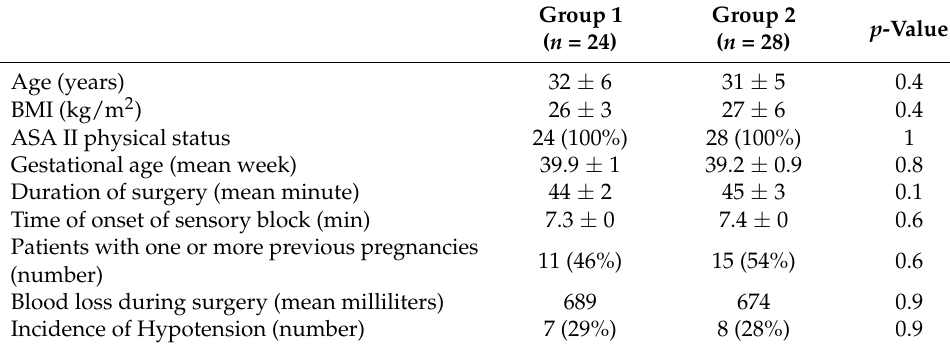
Table 1. Demographic and surgical characteristics.